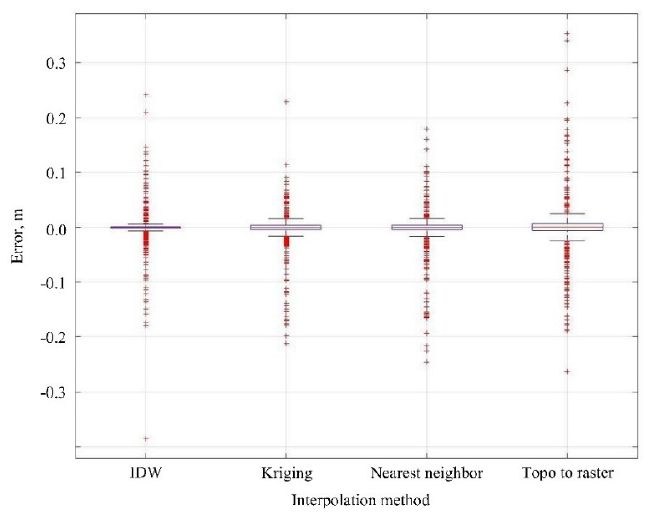
Figure 4. Box plots of the errors of different interpolation methods compared to measured elevation values.